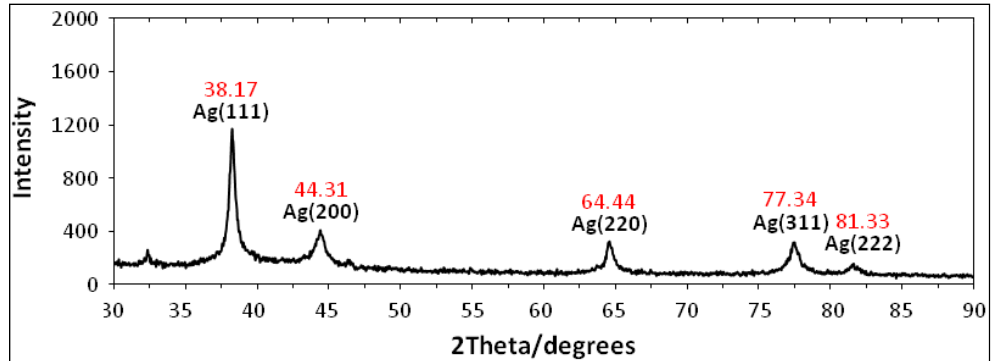
Figure 3. XRD patterns of Ag-NPs synthesized in Vitex negundo for determination of silver crystals after 48